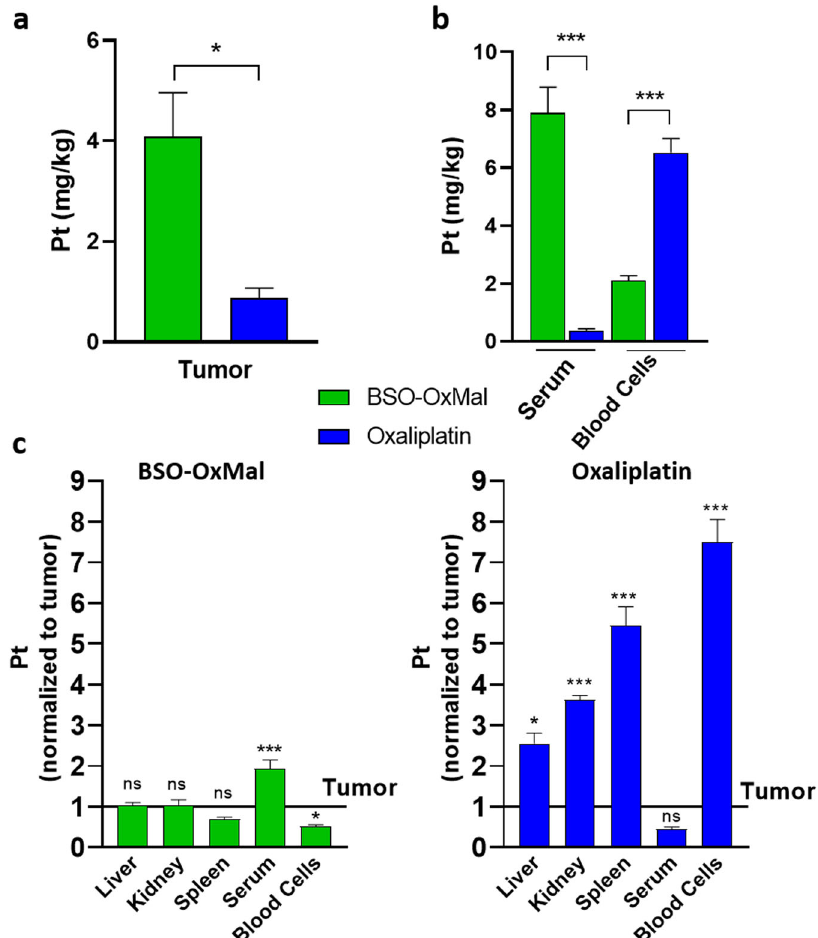
Fig. 7 Tissue/organ distribution of BSO-OxMal compared to free oxaliplatin. Mice bearing CT26 allografts ( n = 4 per group) were treated twice a week with equimolar concentrations of BSO-OxMal (23.5 mg/kg) or oxaliplatin (9 mg/kg) and sacri fi ced 24 h after the last drug dosing. Platinum contents of tumor tissue ( a ) and serum as compared to blood cells ( b ) was determined by ICP-MS. Statistical differences were tested by Student´s t -test. ( c ) Platinum levels in the indicated organs are given relative to the ones in the tumor tissue. Data are depicted as mean ± SD. Statistical signi fi cance was tested for all tissues/organs as compared to platinum levels in tumor tissue using one-way ANOVA. In all cases: * p < 0.05; *** p <